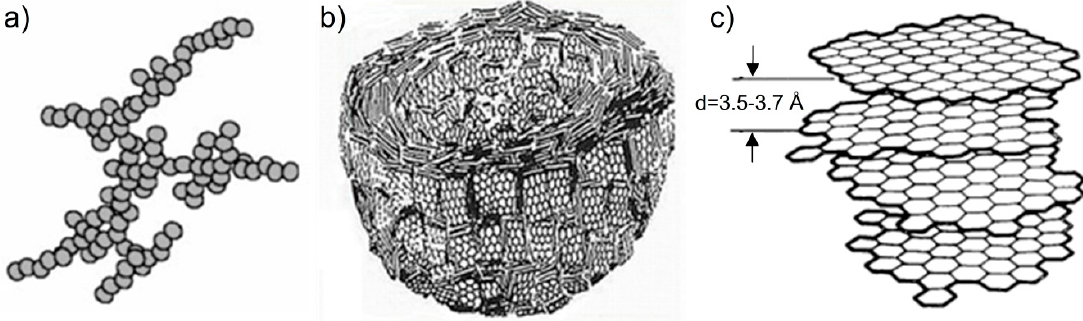
Figure 5. Multiscale structure of carbon black. ( a ) Model of a primary carbon black aggregate. Reproduced with permission from Brasil et al. [41]. Copyright AIP Publishing, 1999. ( b ) Model of a carbon black particle showing the arrangement of the turbostratic domains. ( c ) Model of a carbon black turbostratic domain. Reproduced with permission from Heidenreich et al. [36]. Copyright International Union of Crystallography, 1968.